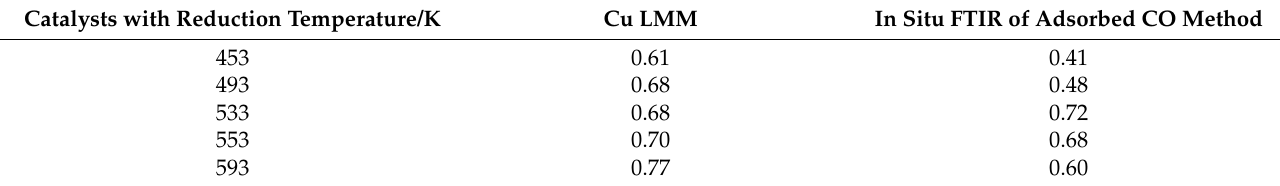
Table 6. Determination of Cu 0 /(Cu 0 + Cu + ) ratio by various CMA-L characterization